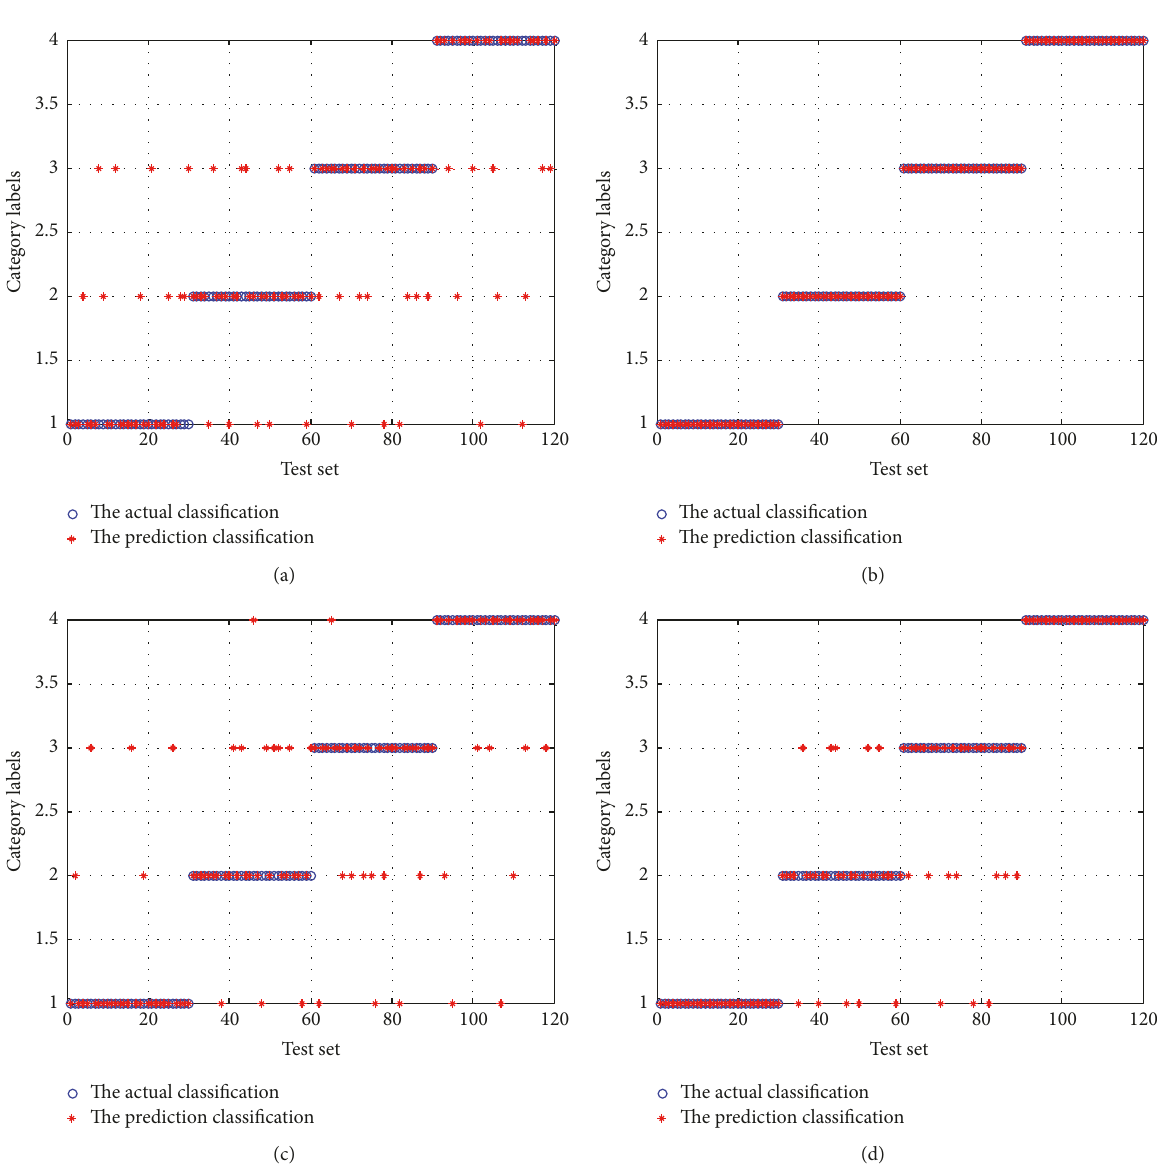
Figure 10: Test classification: (a) LCD-ELM method, (b) ELCD-ELM method, (c) EMD-ELM method, and (d) LMD-ELM